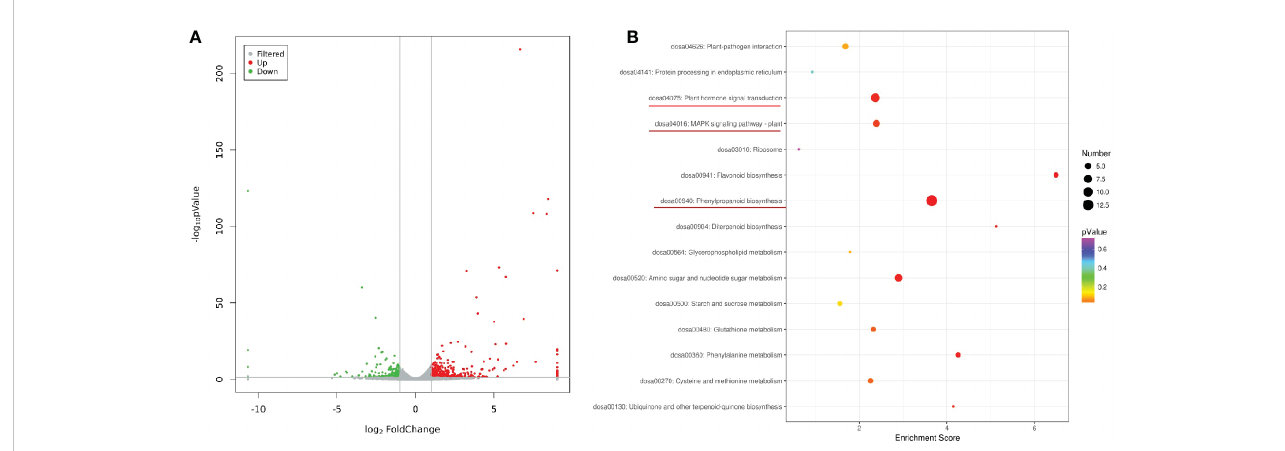
FIGURE 3 DEGs analysis and KEGG enrichment analysis of the DEGs. (A) The volcano map presents the differentially expressed genes (FDR < 0.05 and >= 2-fold change) between the line 5 and the wild type based on leaf transcriptome analysis. (B) KEGG pathways with enrichment of signi fi cantly upregulated and downregulated genes. Plant hormone biosynthesis genes and plant defense genes are underlined in